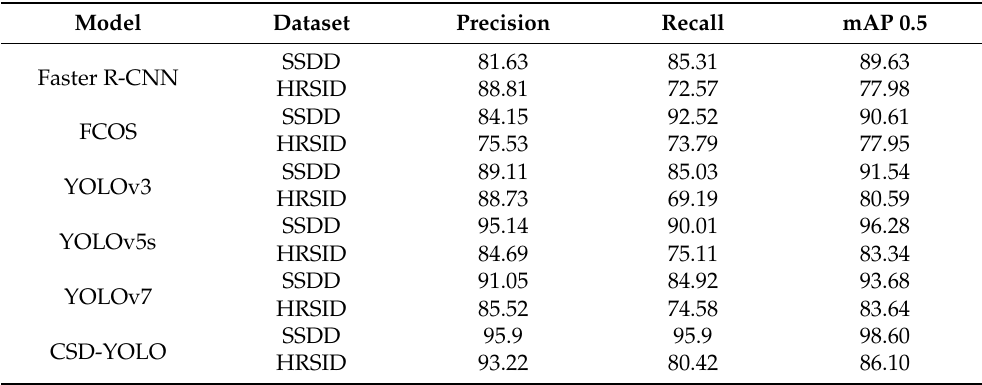
Table 4. Experimental results of different